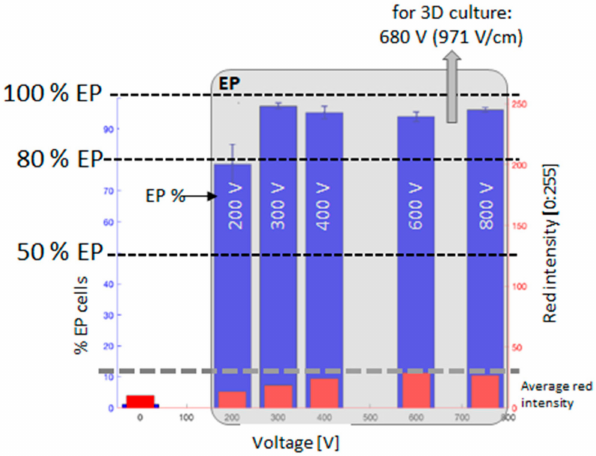
Figure 12. The percentage of electroporated cells and red intensity average as a function of the amplitude of the sequence of 8 voltage